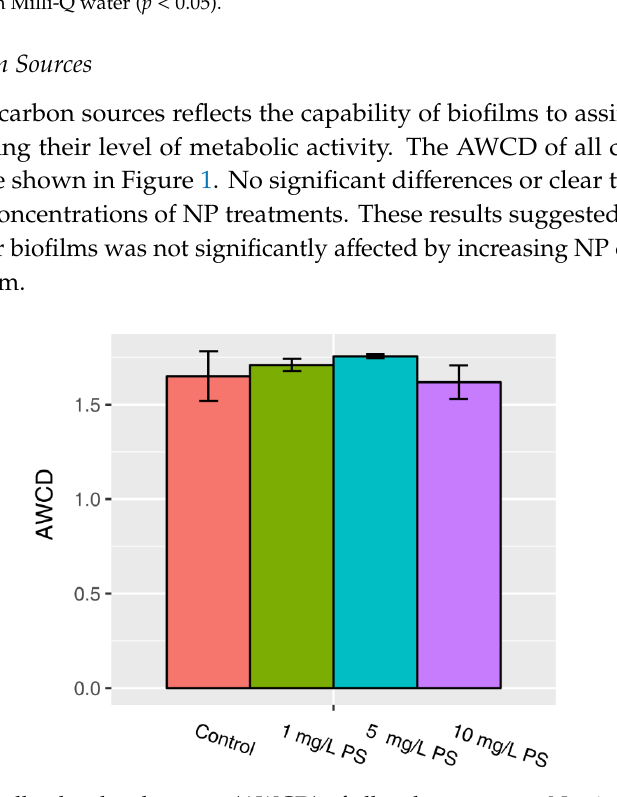
Figure 1. Average well-color development (AWCD) of all carbon sources. No significant difference ( p > 0.05) was observed between the PS-introduced groups and the control.